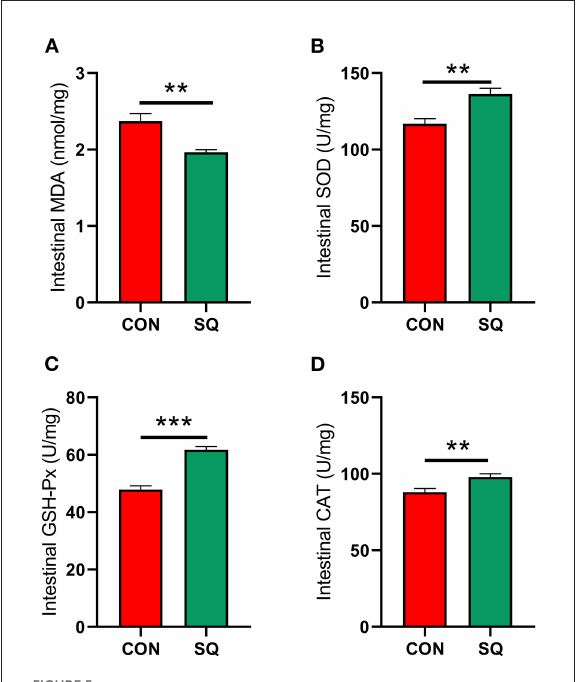
FIGURE5 SQ benefits gut antioxidant capacity. (A–D) Antioxidant index of jejunum. Y-axis = amount, X-axis = the treatment groups. ** P < 0.01; *** P <